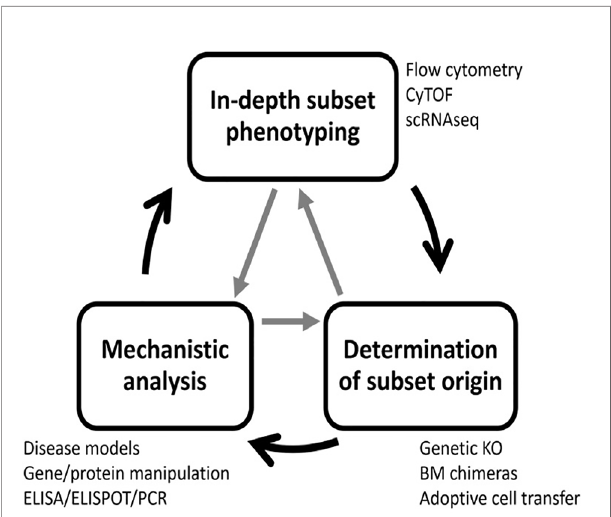
FIGURE 3 | A three-step process to identify regulatory B cell subsets. Complete characterization of novel regulatory B cell subsets requires three steps: subset phenotyping, lineage determination, and functional analysis. To accomplish this goal, many experimental techniques are required.